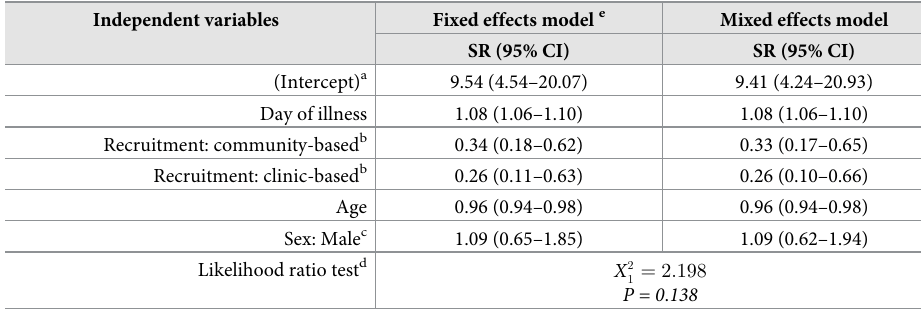
Table 3. Model comparison.